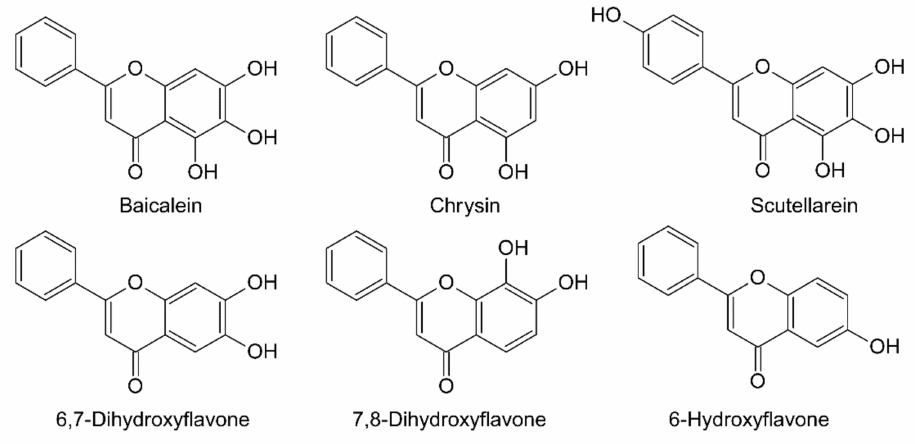
Figure 1. Chemical structures of the flavonoids used in this